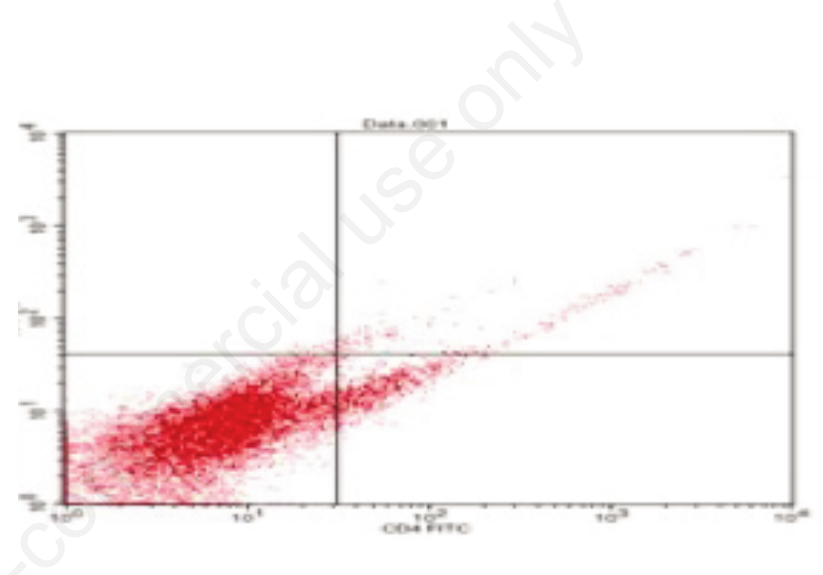
Figure 1. T lymphocyte (CD4 + ) cells expression (6.91%) in the saliva of Caries Free.